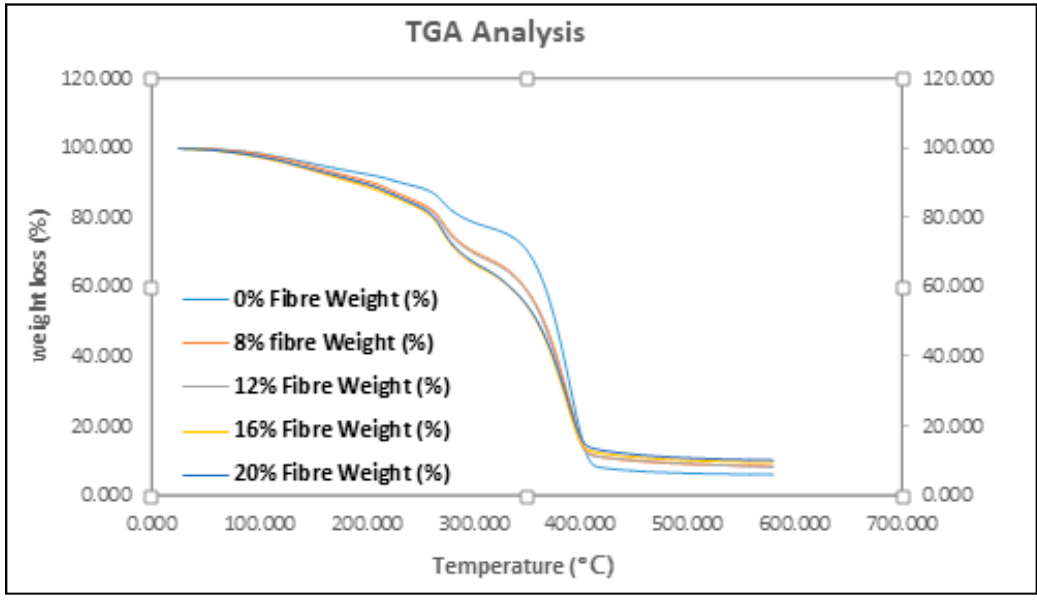
Figure 5. TGA profiles of EFB composites. Table 3. A summary of peak temperatures for EFB composites.